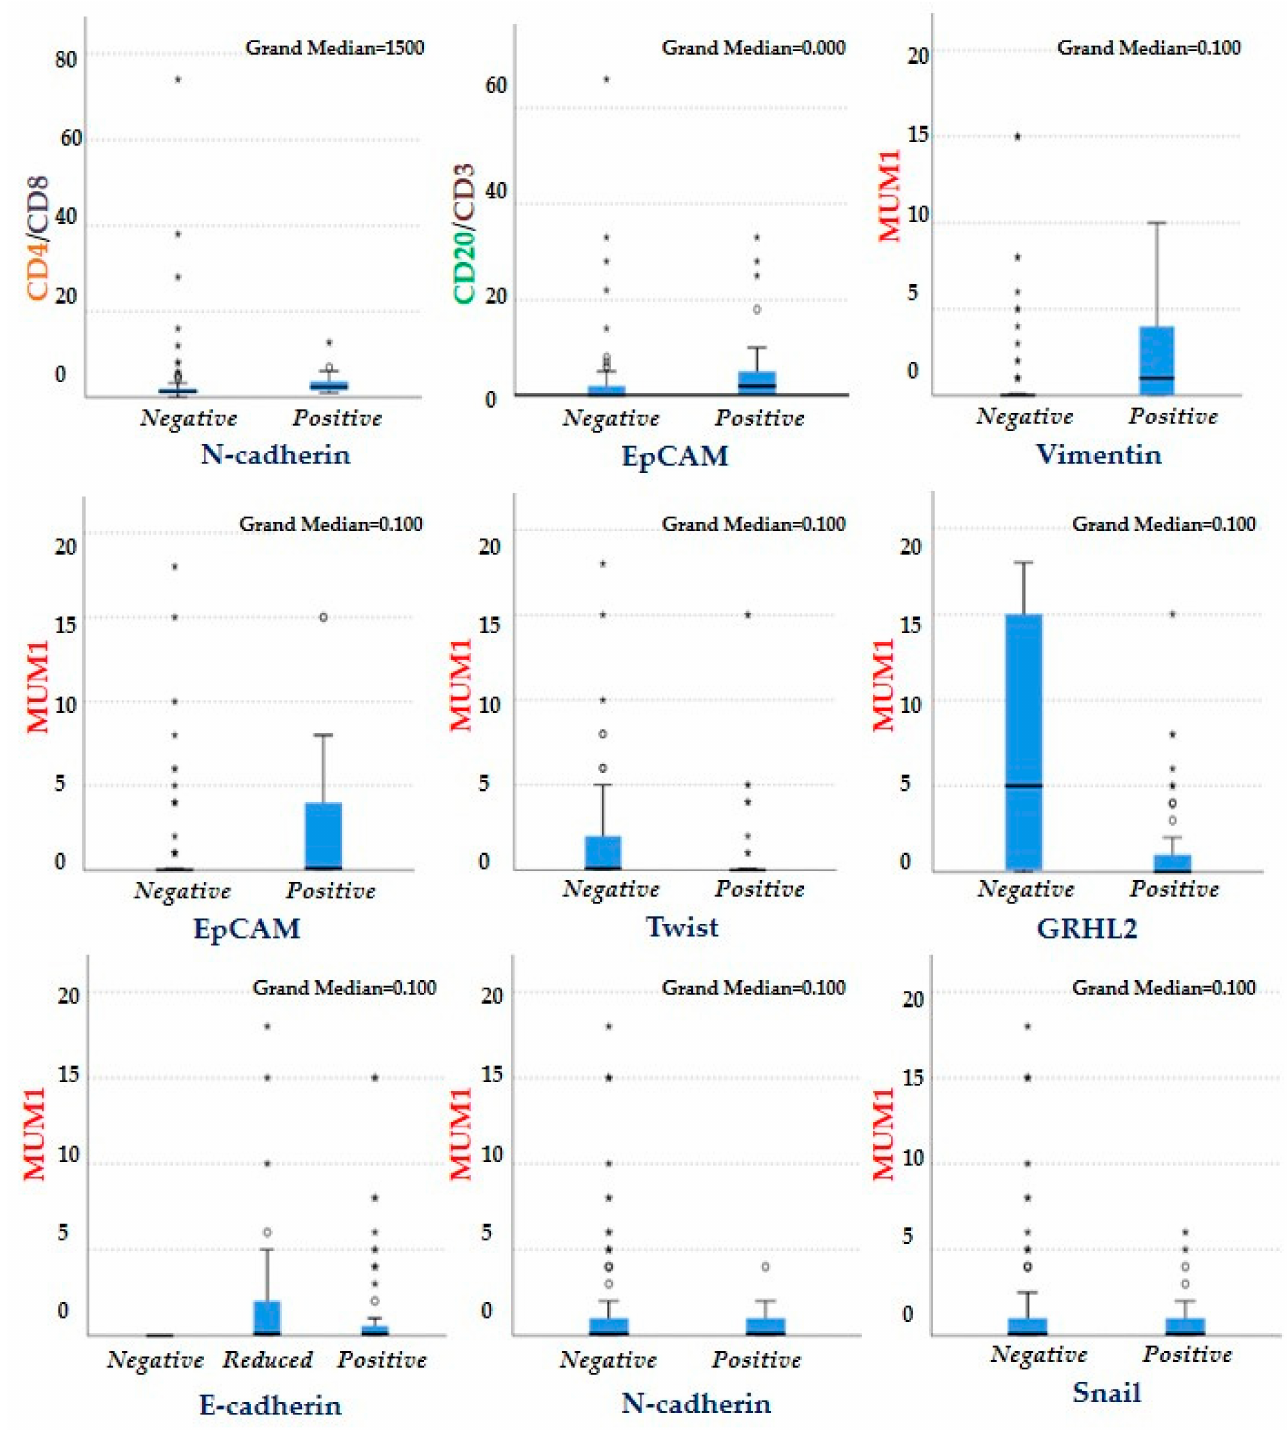
Figure 5. Association between the EMT-related markers and markers of immune cells present in the TME using the independent samples median test. Cases that expressed N-cadherin were generally more infiltrated with CD4 helper T cells ( p = 0.004) than negative cases, while cases that expressed EpCAM were more infiltrated with B lymphocytes (CD20) than cases that failed to express this marker ( p = 0.03). Cases that expressed Vimentin and EpCAM were more infiltrated with plasma cells than those that did not express them ( p = 0.001, p = 0.008, respectively), where as cases that expressed Twist and GRHL2 were less infiltrated by plasma cells ( p = 0.039 and p = 0.03, respectively). Cases that did not express E-cadherin were not infiltrated by plasma cells ( p = 0.005). *, ◦ :